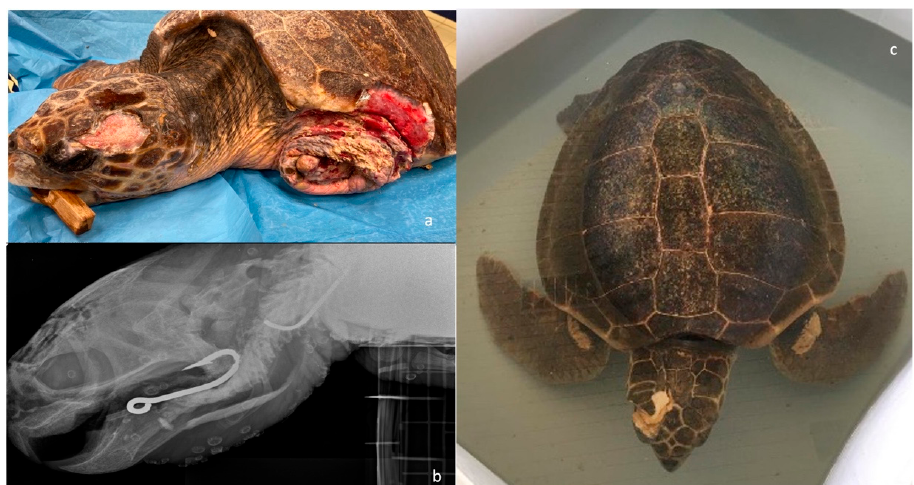
Figure 5. Examples of concomitant pathologies in sea turtles hospitalized for head trauma at the STC.